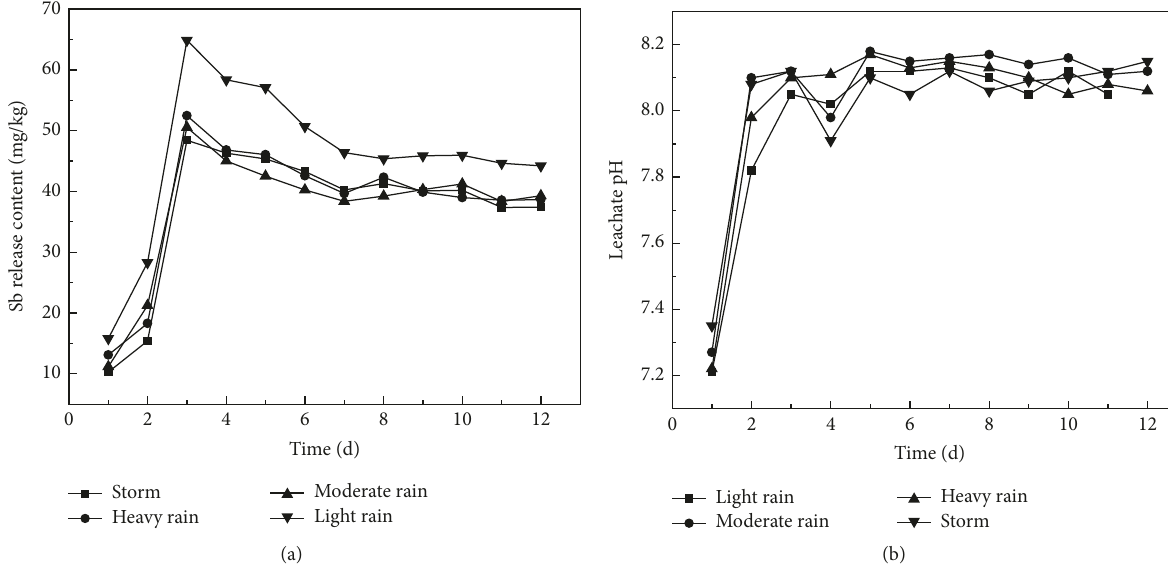
Figure 9: Change of pH and release amount of Sb in different rainfall intensity.